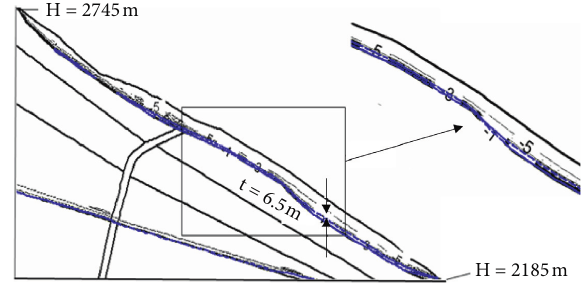
Figure 9: Pressure head distribution of Profile A-A’ in zone I in four days after rain (unit: m). Table 2: Computational parameters for strata of Zhenggang landslide.